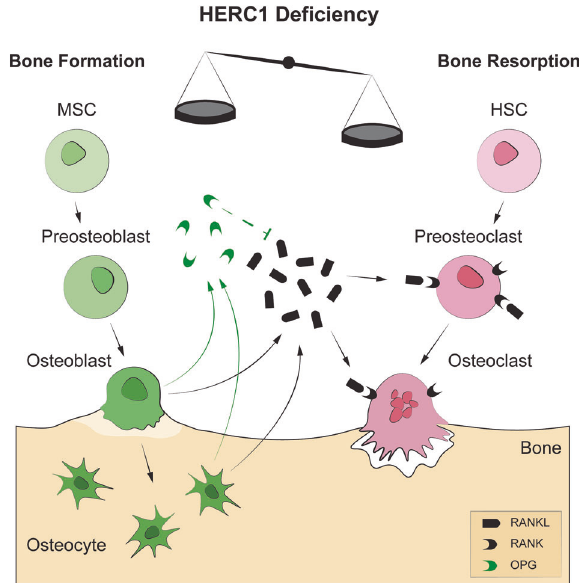
Fig. 8 Schematic model showing the role of HERC1 in bone homeostasis. Osteoblasts and osteocytes secrete RANKL, which then binds to its receptor (RANK) on the membranes of pre- osteoclasts/osteoclasts to increase osteoclastic differentiation and activation, resulting in bone resorption. Secreted OPG then binds to RANKL, inhibiting RANK signaling and bone resorption. Morpho- metric analysis of bones from adult Herc1 -KO mice revealed osteopenia, indicating an imbalance between bone formation and bone resorption. This led to increases in the Rankl/Opg ratio and in the number of osteoclasts. HSC hematopoietic stem cell, MSC mesenchymal stem cells, OPG osteoprotegerin, RANKL RANK ligand, RANK receptor activator of nuclear factor κ p38 dependent on RAF activity [52]. Now, our data show that HERC1 depletion during osteogenic differentiation causes an increase in C-RAF levels, thereby activating ERK and p38 (Fig. 1).